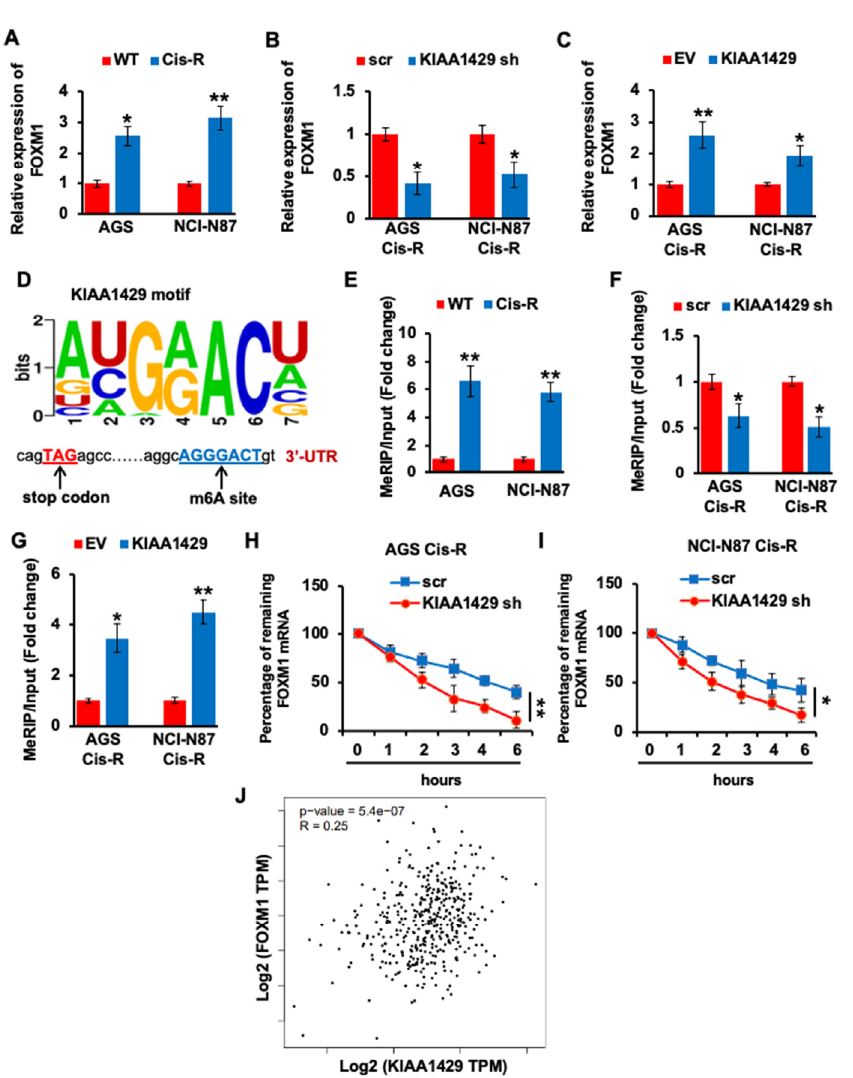
Figure 4. Effect of KIAA1429 on regulating FOXM1 expression. ( A ) The mRNA level of FOXM1 in AGS Cis-R or NCI-N87 Cis-R and their parental wild type cells was assessed by QRT-PCR. ( B , C ) The mRNA level of FOXM1 in KIAA1429 shRNA infected ( B ) or KIAA1429 overexpressed ( C ) AGS Cis-R or NCI-N87 Cis-R cells was assessed by QRT-PCR. ( D ) Schematic diagram demonstrated the m 6 A motif of KIAA1429 and the m 6 A site in the 3 ′ -UTR of FOXM1 mRNA (near stop codon). ( E ) MeRIP assay indicated the FOXM1 mRNA enrichment precipitated by m 6 A antibody in AGS Cis-R or NCI-N87 Cis-R and their parental wild type cells. ( F , G ) MeRIP assay indicated the FOXM1 mRNA enrichment precipitated by m 6 A antibody in KI-AA1429 shRNA infected ( F ) or KIAA1429 overexpressed (G) AGS Cis-R or NCI-N87 Cis-R cells. ( H , I ) RNA decay rate assay demonstrated the FOXM1 mRNA half-lives upon the KIAA1429 knockdown in AGS Cis-R ( H ) or NCI-N87 Cis-R ( I ) cells. Data were detected at indicated timepoint with actinomycin D (Act D, 5 μ g/mL) treatment. ( J ) Correlation analysis by Spearman’s rank correlation coefficient (GEPIA) showed the correlation be- tween KIAA1429 and FOXM1 in the gastric cancer tissue specimens. * p < 0.05, ** p < 0.01. 3.5. YTHDF1 Regulated the FOXM1 mRNA Stability in Gastric Cancer Cells Although we proved that the expression of FOXM1 is regulated by KIAA1429, the underlying mechanism by which KIAA1429 stabilized the mRNA of FOXM1 remains un- clear. YTH m 6 A RNA binding protein (YTHDF1) is one of the “readers” of m 6 A methyl- transferase. We first performed RNA immunoprecipitation (RIP) assay and found that YTHDF1 bound the same m 6 A motif with KIAA1429 in FOXM1 CDS, and more binding was observed in cisplatin resistant GC cells (Figure 5A). More importantly, YTHDF1